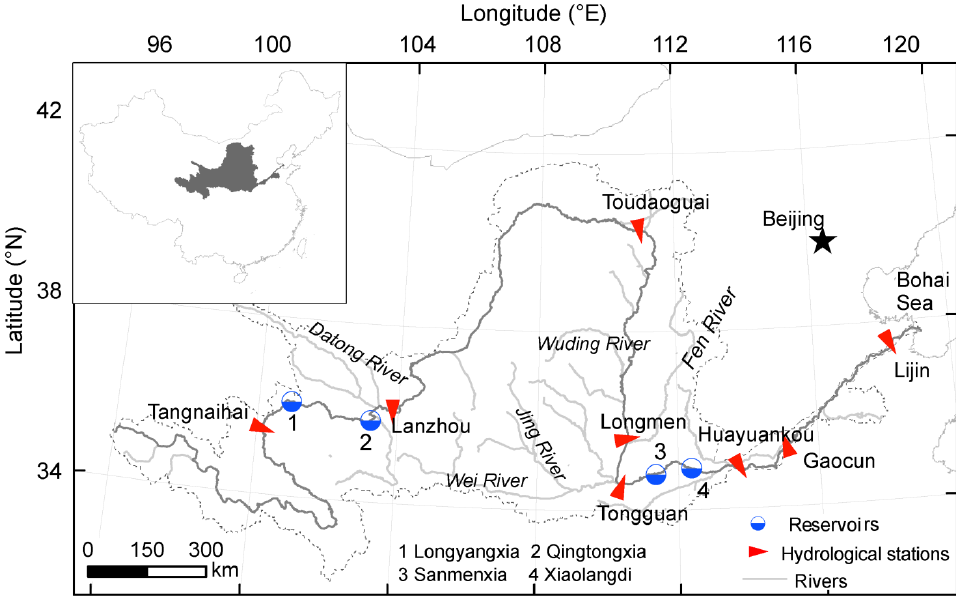
Figure 1. Location of the study area and hydrological stations.